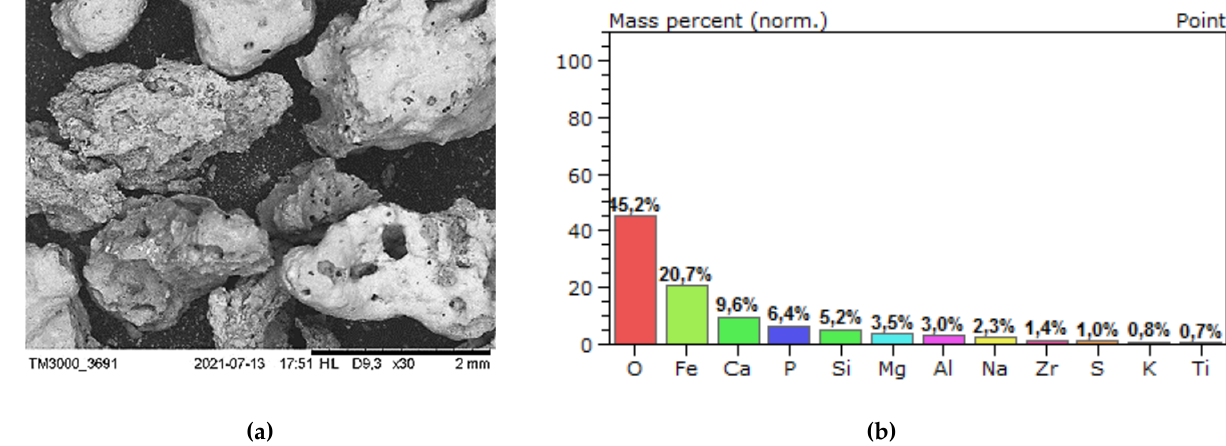
Figure 5. (a) Waste aggregate (A FSS ) grains—magnification of 30×; (b) identification of elements. Figure 5. ( a ) Waste aggregate (A FSS ) grains—magnification of 30 × ; ( b ) identification of Phosphates in the presence of lime (Ca) found in the fresh paste can cause precipita- tion of the poorly soluble calcium phosphate Ca 3 (PO 4 ) 2 on the surface of cement grains.